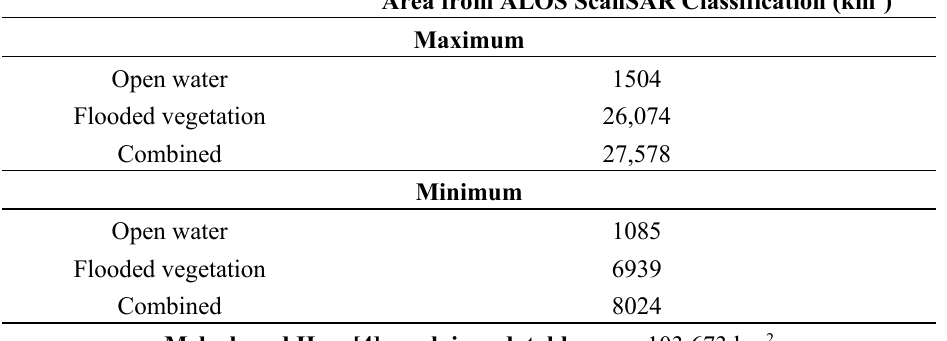
Table 7. Results from within the inundatable mask for Pacaya-Samiria, Peru and surrounding